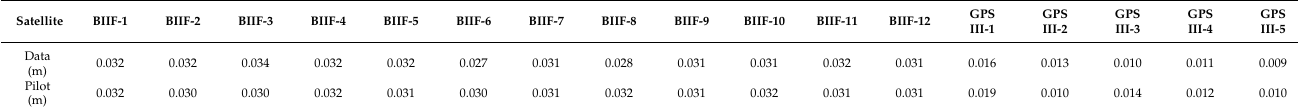
Table 2. Maximum SCB range.